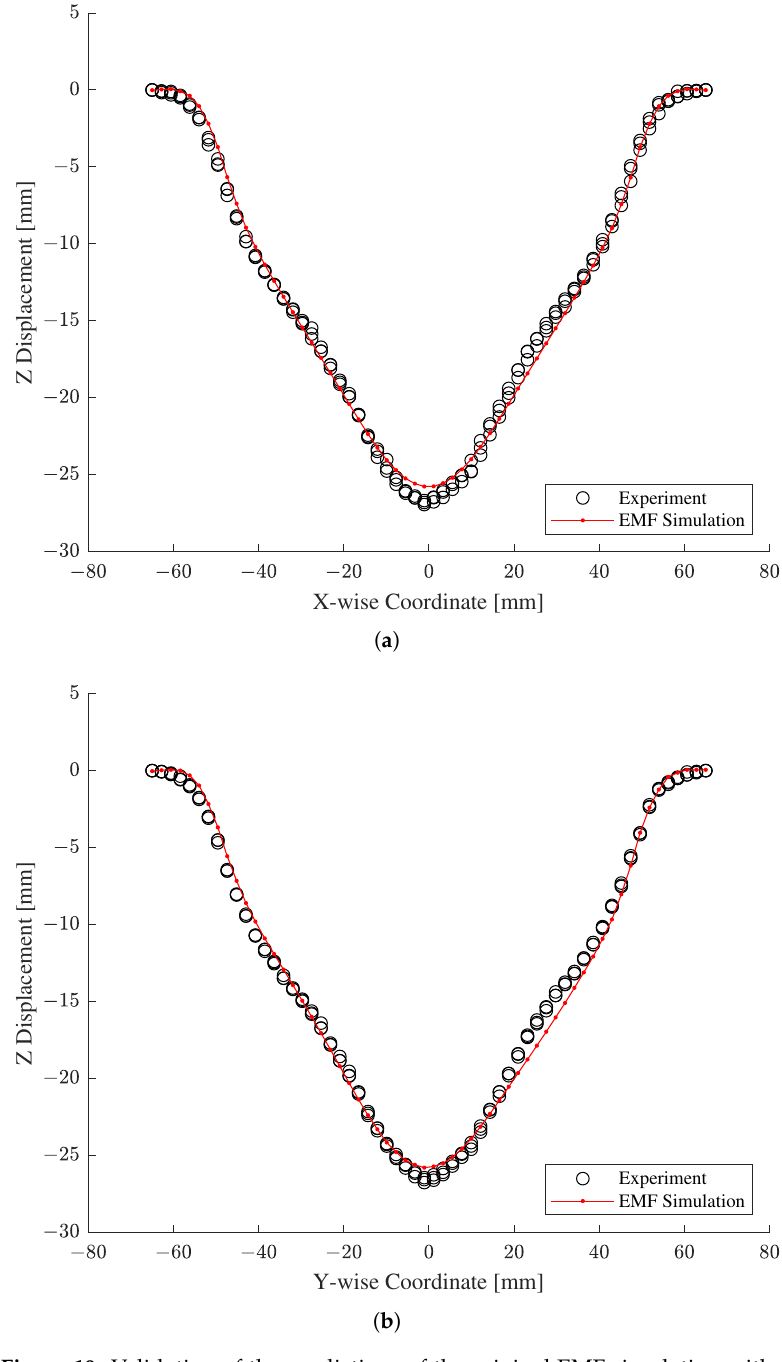
Figure 19. Validation of the predictions of the original EMF simulation with respect to the actual measurements. ( a ) X-wise coordinates. ( b ) Y-wise